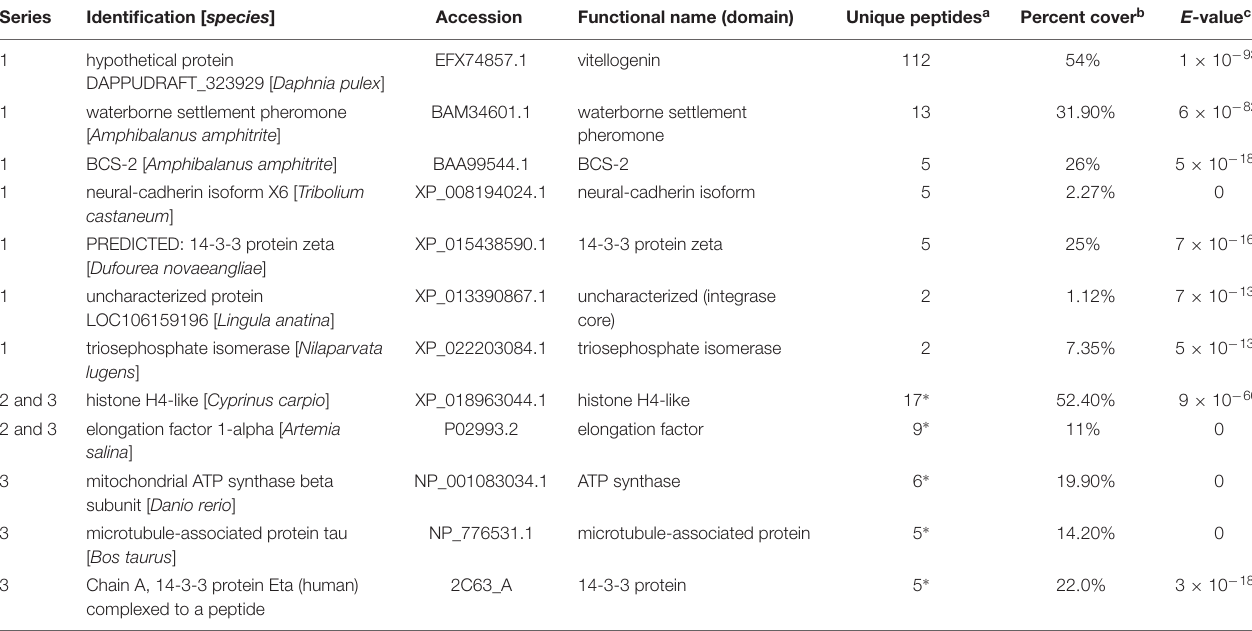
TABLE 4 | Other proteins identified in barnacle secretions by LC-MS/MS based on peptides identified and sequence coverage.